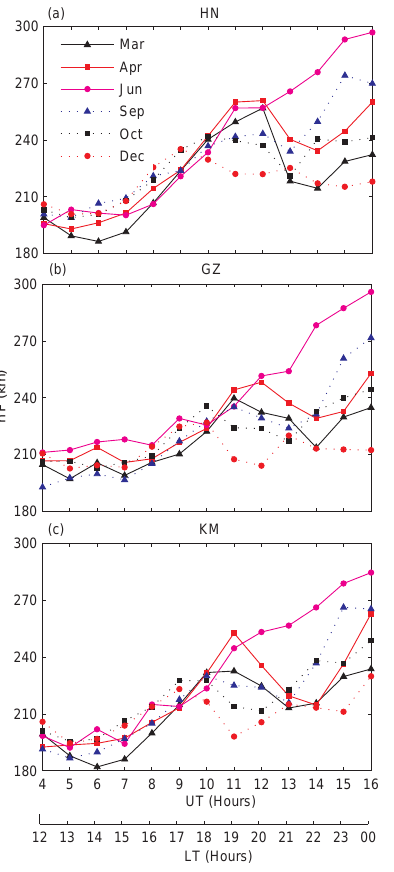
Figure 4. Six months of temporal variations of the monthly mean h (cid:48) F at the three stations in 2013.